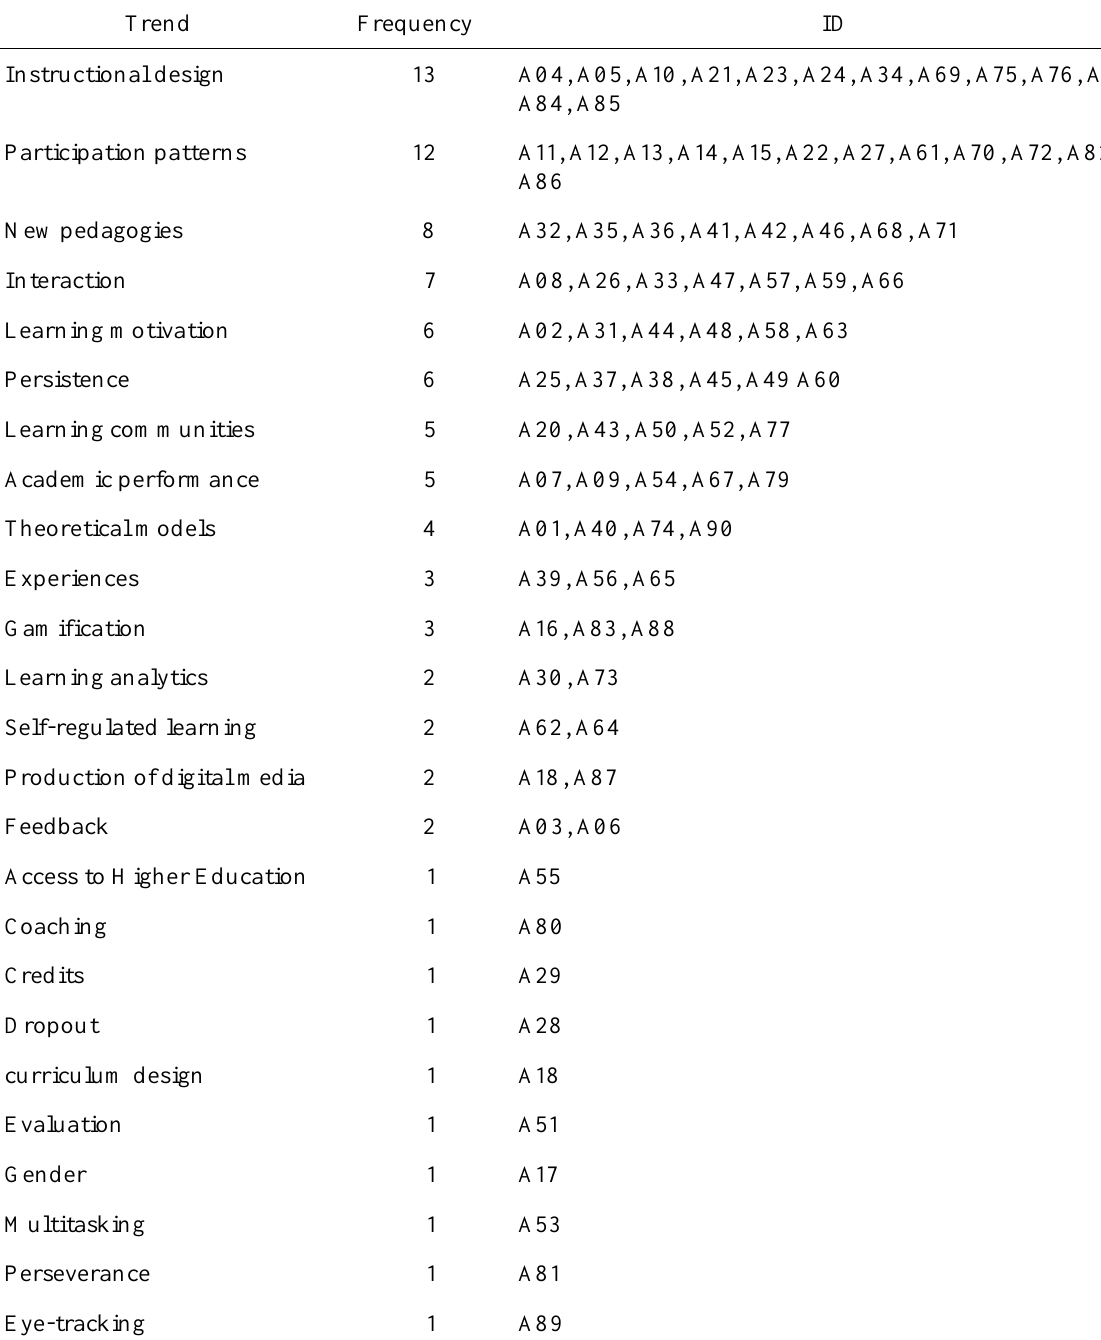
Table 10 Research Trends in the Study of Academic Engagement in MOOCs